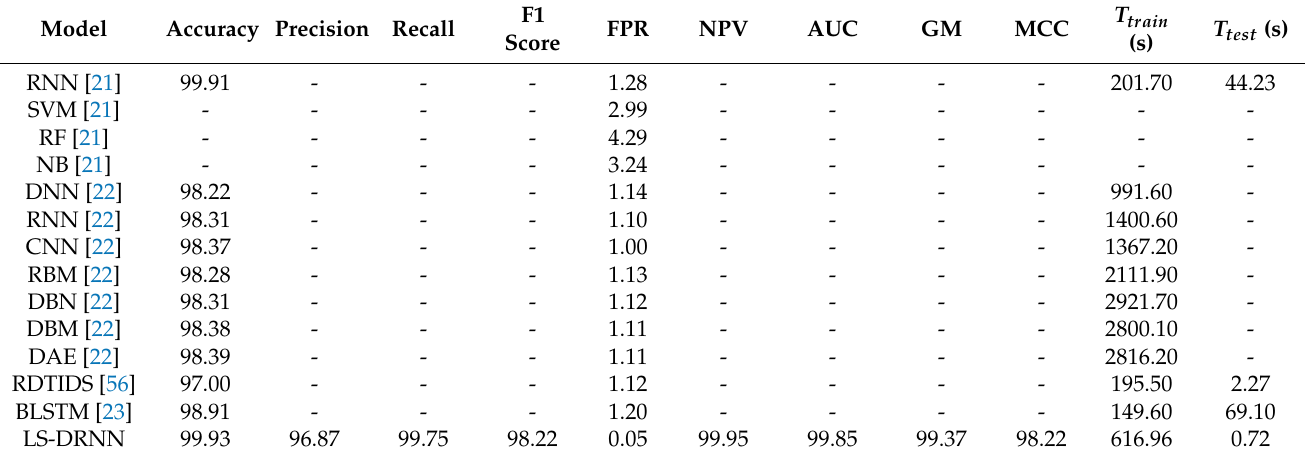
Table 9. Overall classification performance of ML and DL